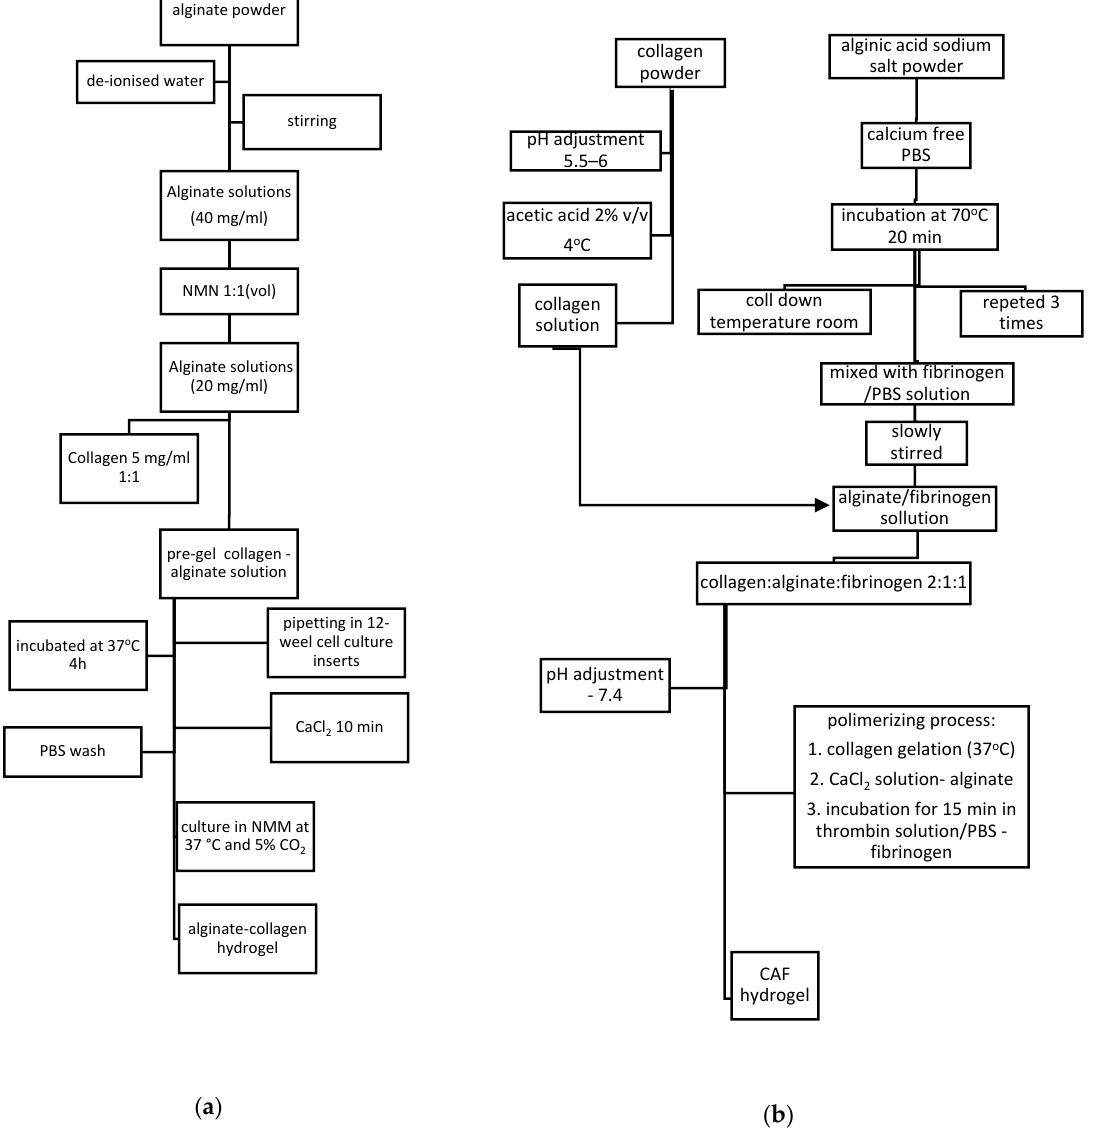
Figure 5. ( a ) Synthesis of collagen–alginate from pre-gel solution 20 mg/mL alginate and 5 mg/mL collagen. ( b ) Synthesis of collagen–alginate-fibrinogen (CAF) 2:1:1 hydrogel.